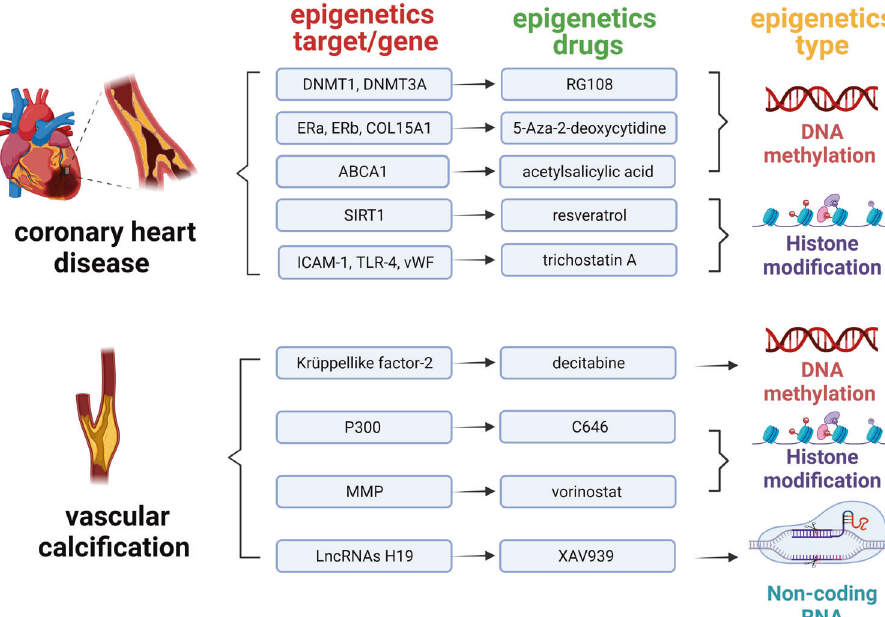
Fig. 6 Epigenetics-related targets and drugs in coronary heart disease and vascular calci fi cation. This fi gure was created with the aid of Biorender (https://biorender.com/). DNMTs DNA methyltransferases, ER estrogen receptor, COL15A1 collagen, type XV, alpha 1, ABCA1 ATP- binding cassette transporter A1 gene, SIRT1 sirtuin1, HDAC histone deacetylase, ICAM-1 intercellular adhesion molecule-1, TLR-4 toll-like receptor-4, vWF von Wilebrand factor, MMP matrix